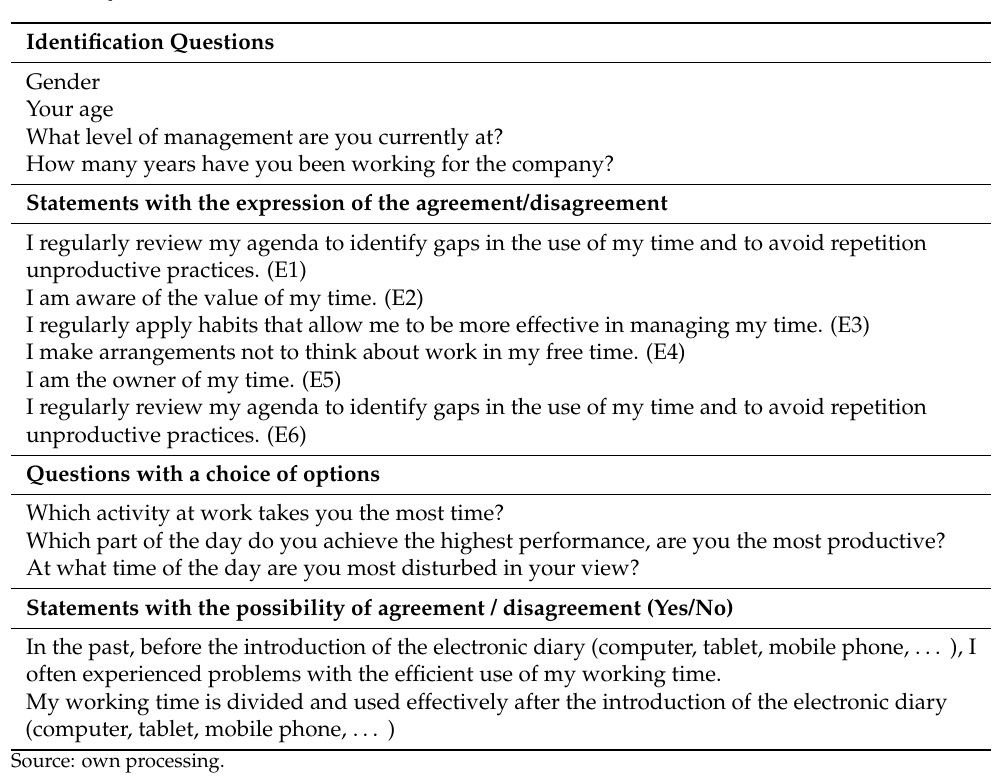
Table 1. Questionnaire.